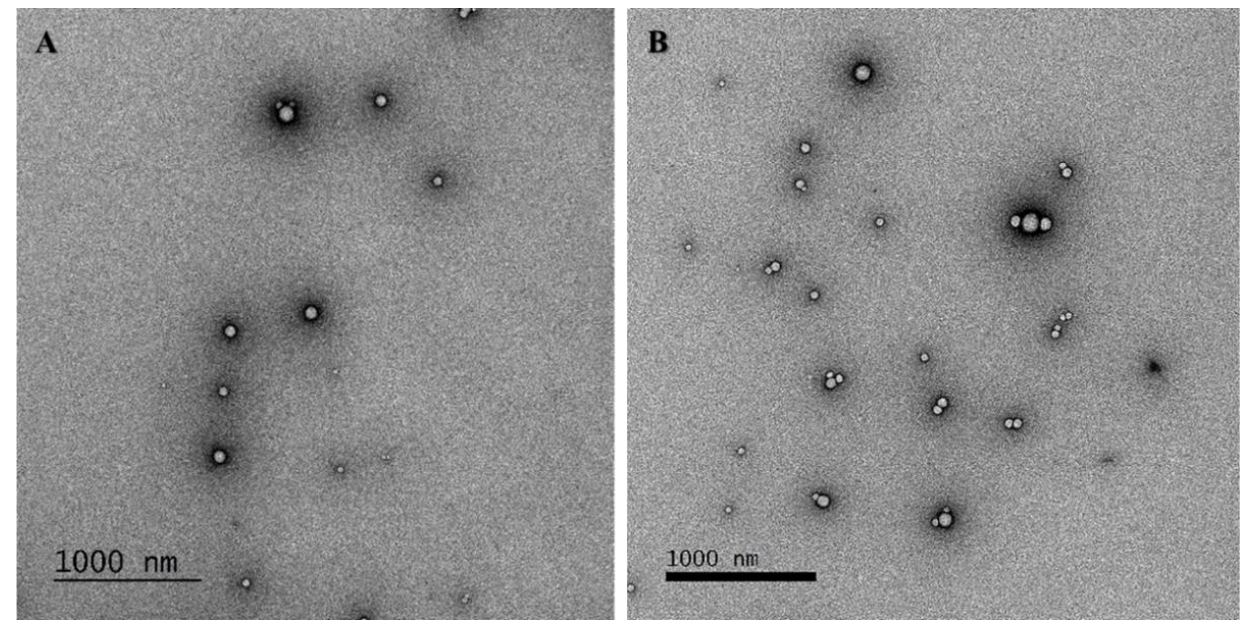
Figure 3. NPs ’ morphology characterization. Representative TEM images of ( A ) PLGA NPs and ( B ) Figure 3. NPs’ morphology characterization. Representative TEM images of ( A ) PLGA NPs and PLGA-HA NPs. ( B ) PLGA-HA